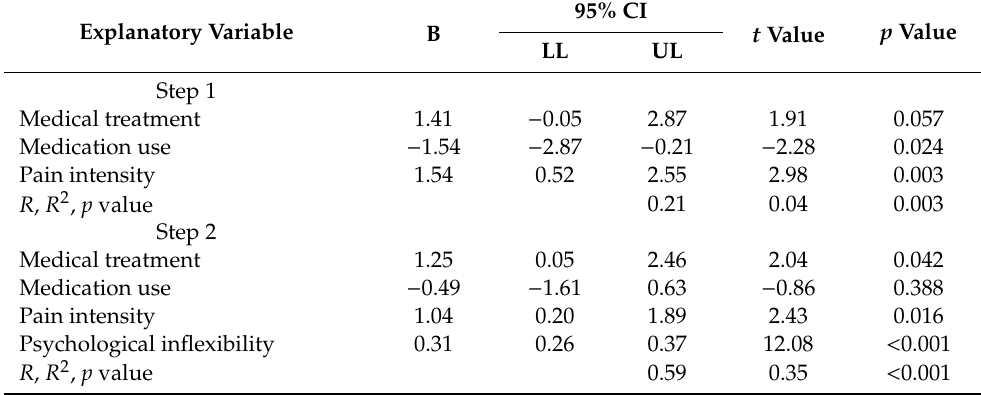
Table3. Hierarchicalmultiple regression analysis on depressive symptoms scorewith medical treatment, medication use, pain intensity, and psychological inflexibility scores as an explanatory variable.